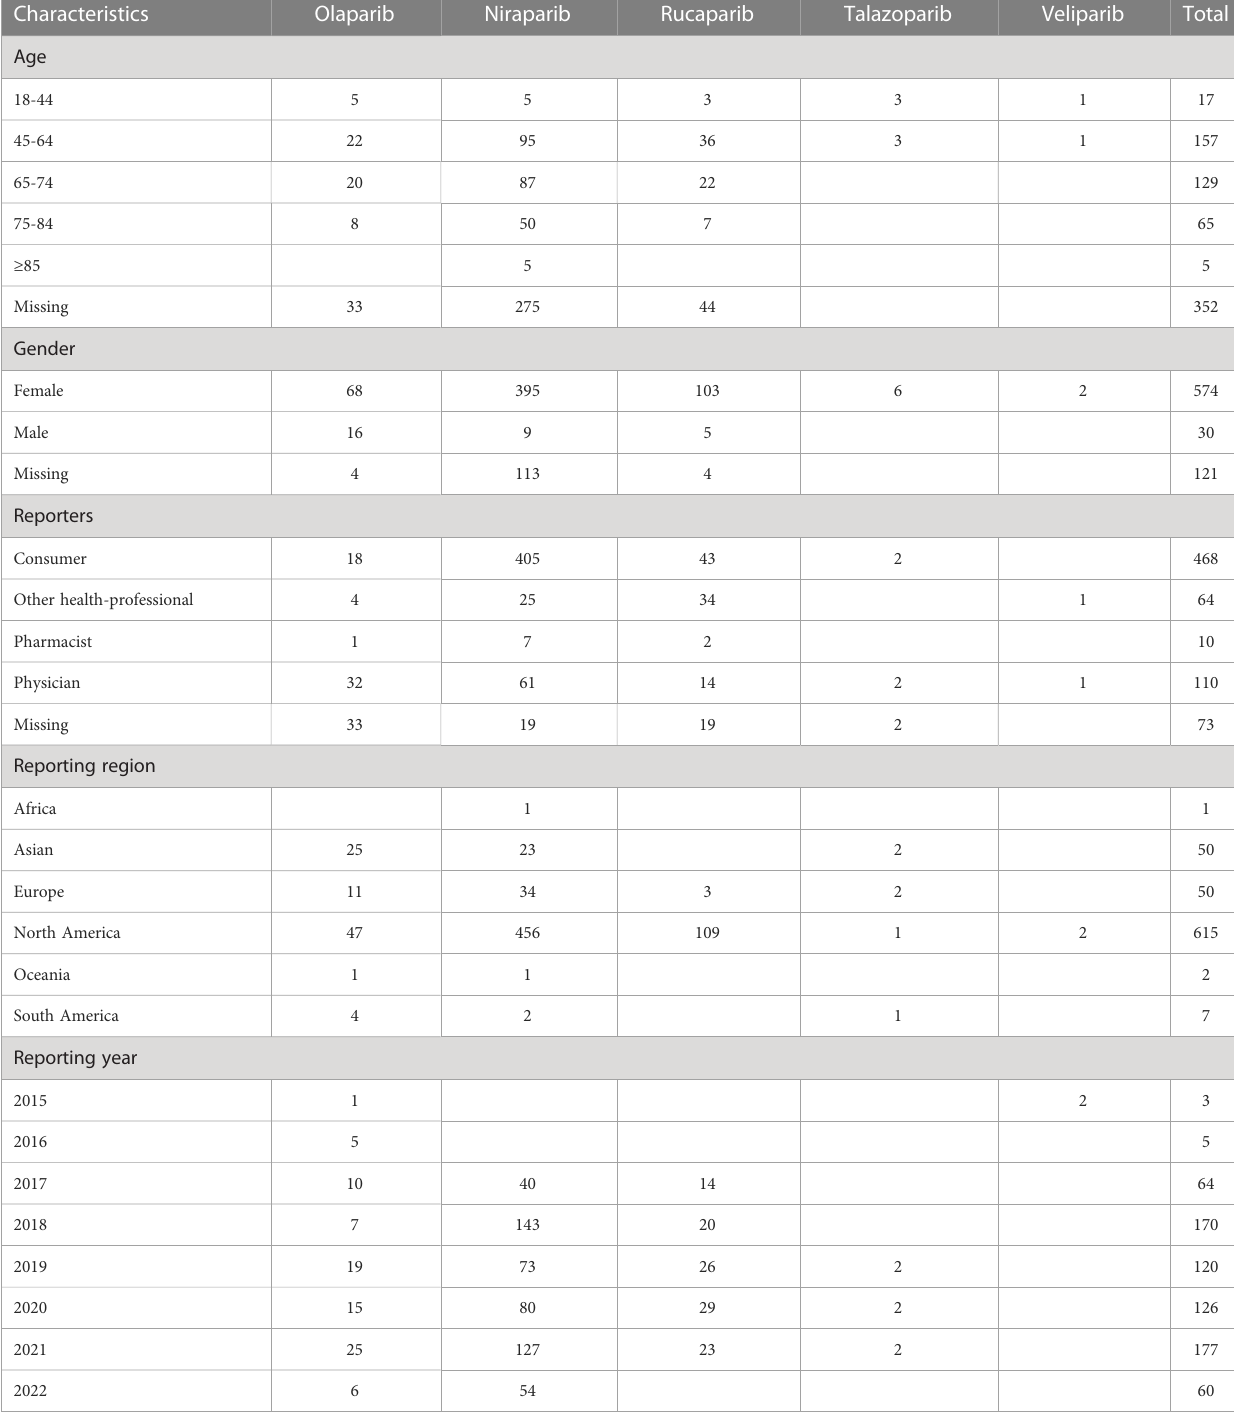
TABLE 2 Characteristics of patients with haemorrhages-related adverse events associated with different